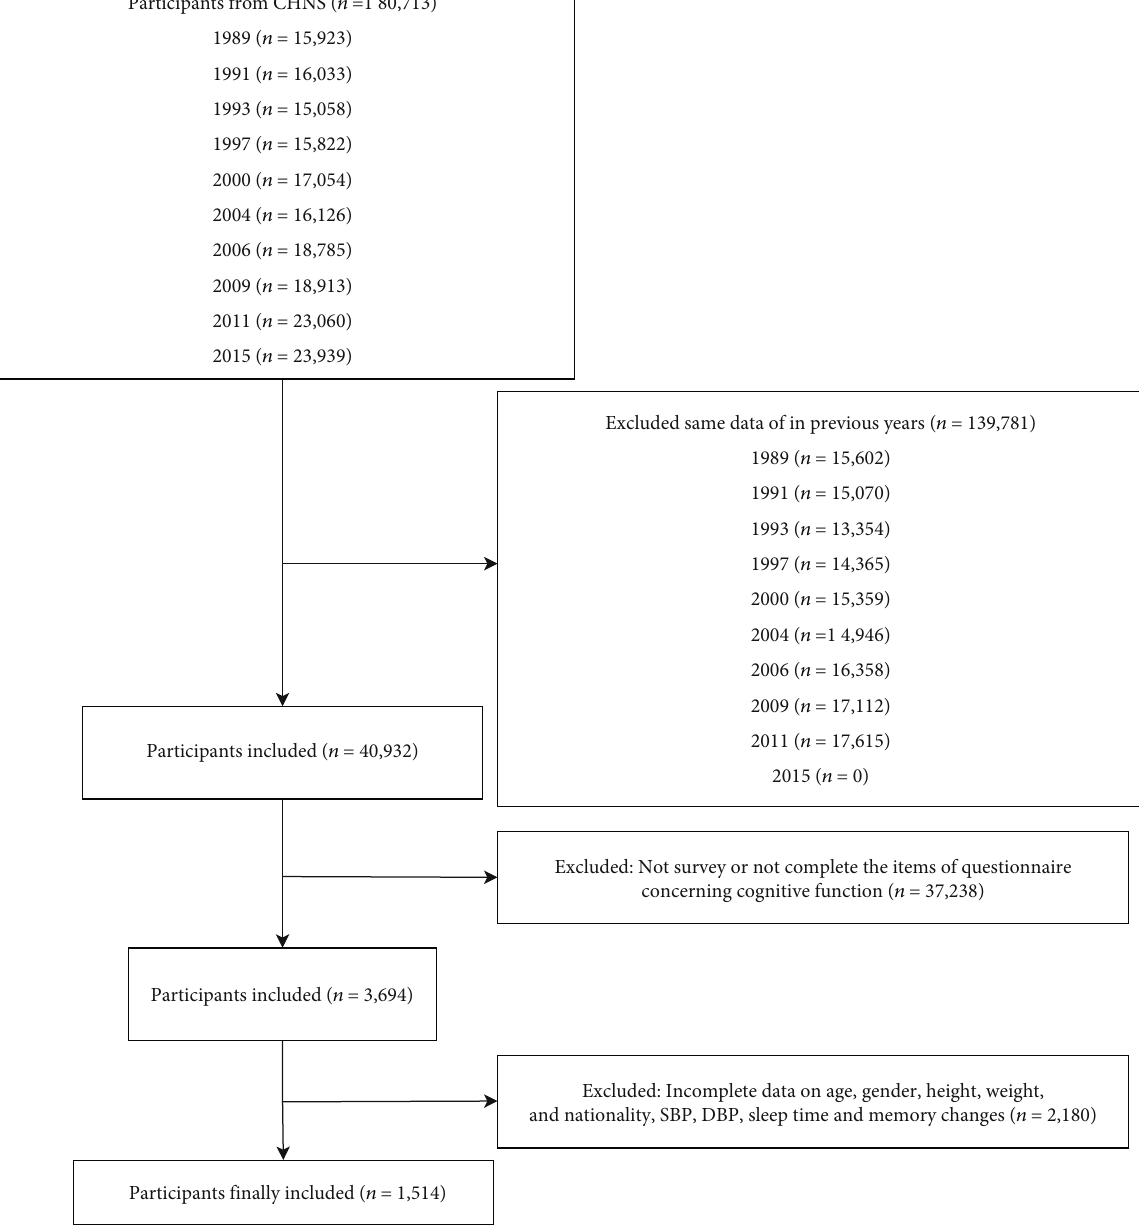
Figure 4: The screening process of the